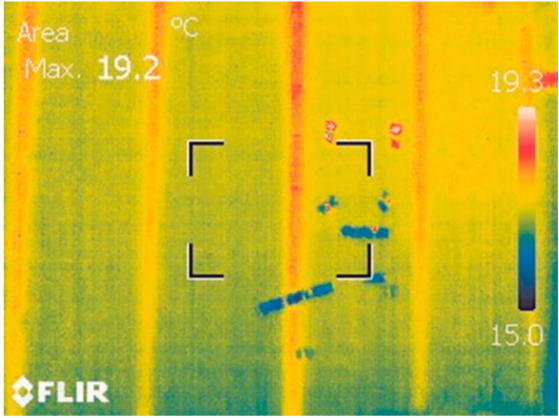
Figure 1. Thermal bridge’s e ff ect due to vertical steel studs in a light steel framed (LSF) wall captured in an infrared thermal image